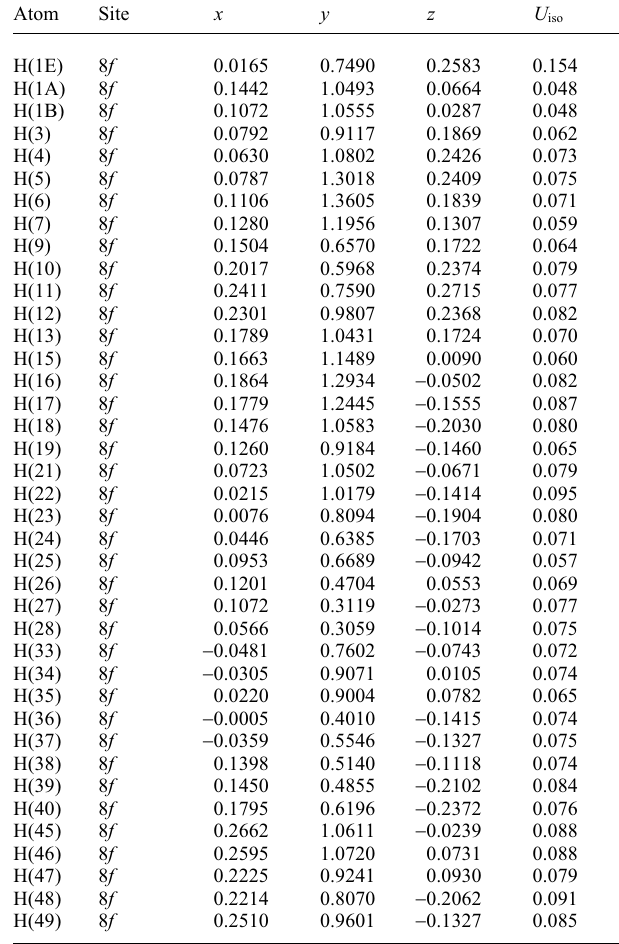
Table 2. Atomic coordinates and displacement parameters (in Å 2 ) . Atom